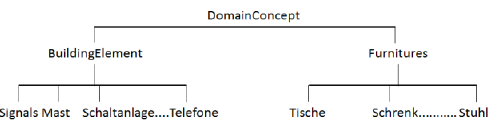
Figure . Taxonomical hierarchical semantics of class Algorithms